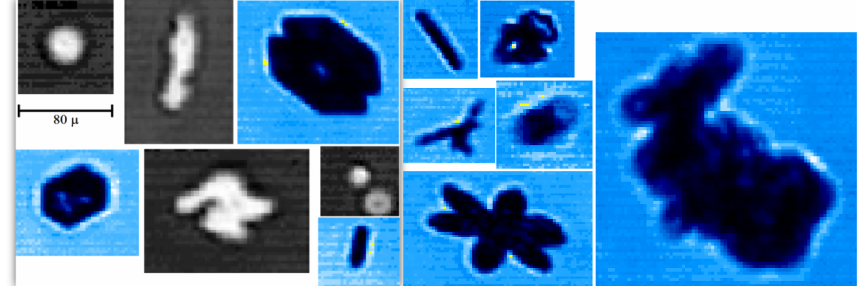
Figure 4. Images of ice particles in CLOUD captured by 3V-CPI with 2µm resolution. Most of the particles are smaller than 100µm (scale on the left).